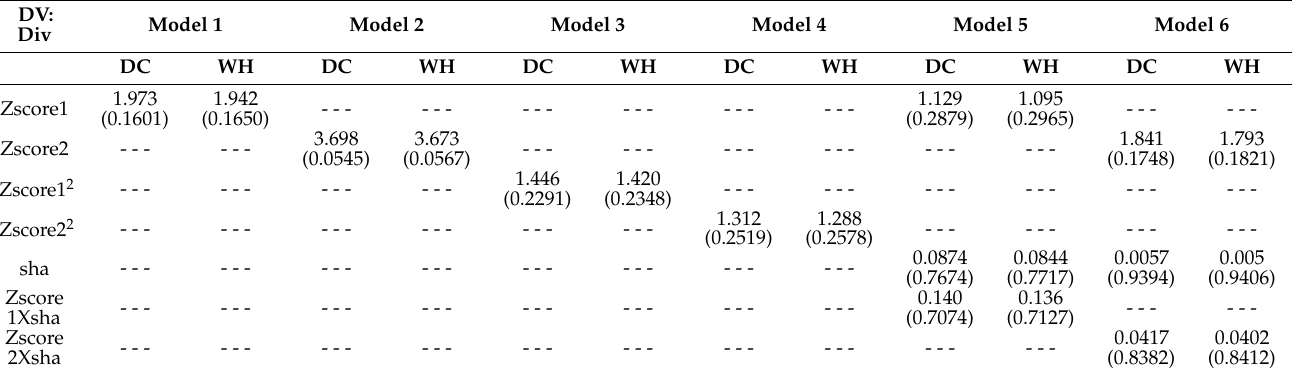
Table 6. Endogeneity